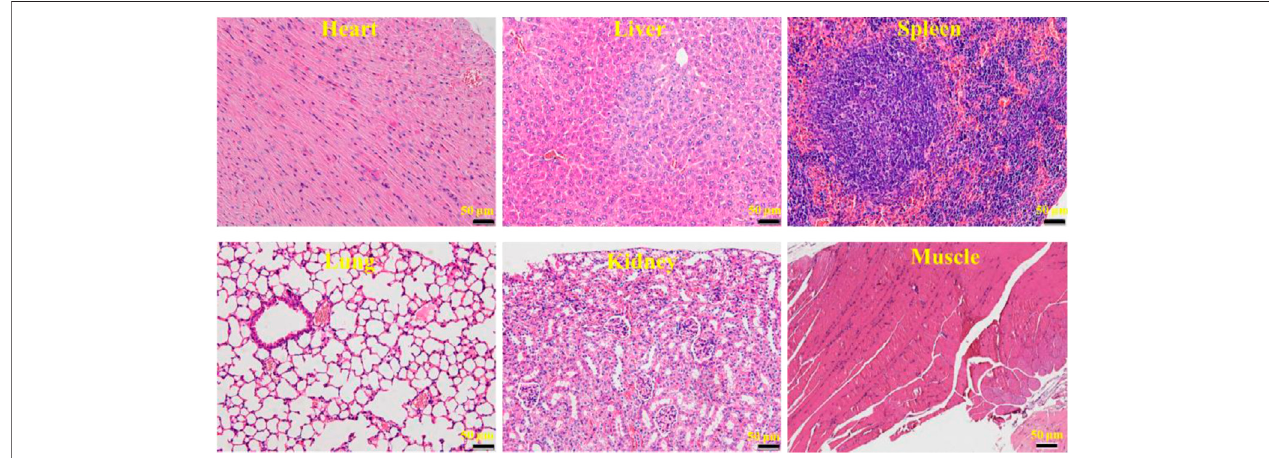
FIGURE 7 | HE micrograph showing no in fl ammation, foreign body, or tumor tissue in the heart, liver, spleen, lung, kidney, and the muscle tissues adjacent to cancer tissues. Bar: 50 μ